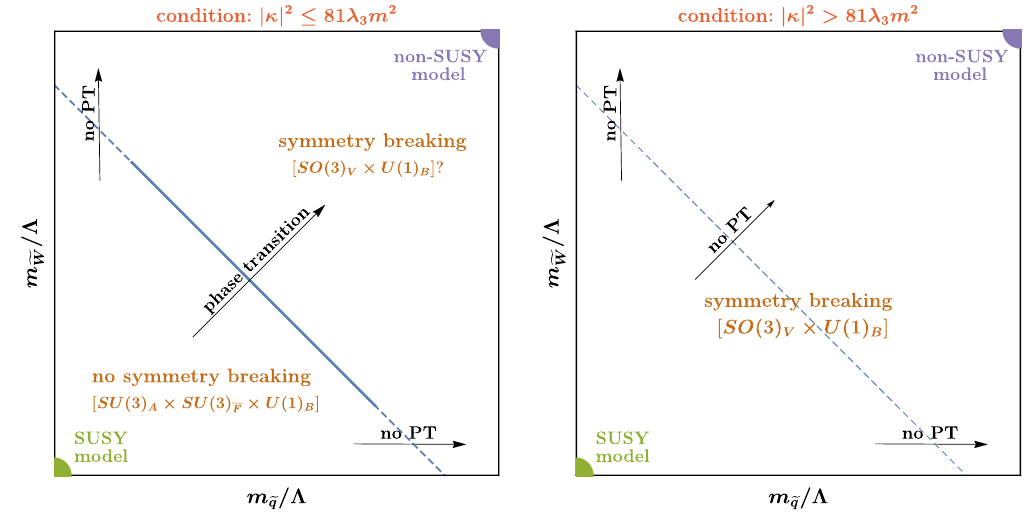
Figure 1 . Left panel: schematic plot to show the phase diagram of the theory in terms of the squark mass m and the gaugino mass m for | κ | 2 ≤ 81 λ 2 (this condition is satisfied for 3 m e q e W anomaly-mediated SUSY breaking.). A phase boundary separating the symmetry-breaking and symmetry-preserving phases exists when both m and m are of order the confinement scale Λ e q e W